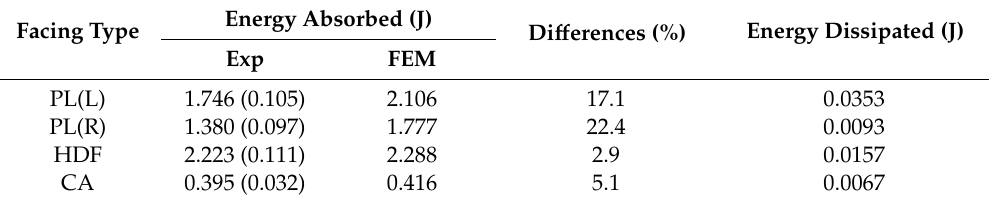
Figure 13. The change in the absorbed energy ( a ) and dissipation of damage energy ( b ) at different deflections. Table 3. Energy absorbed and dissipated during bending (standard deviation in Table 3. Energy absorbed and dissipated during bending (standard deviation in parentheses).